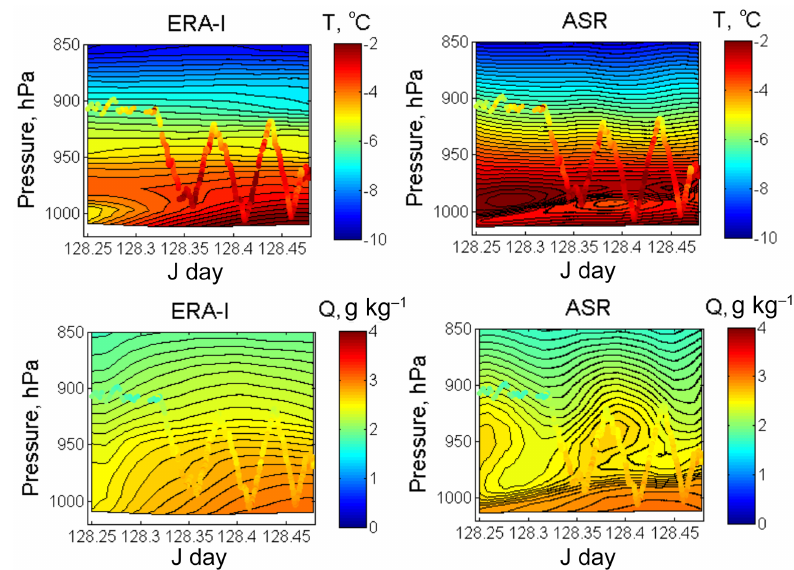
Figure 5. Temperature and specific humidity measured during the CMET flight 4 soundings (filled circles) compared to 4-D interpolated (latitude, longitude, pressure, time) model data from ERA-I and ASR.